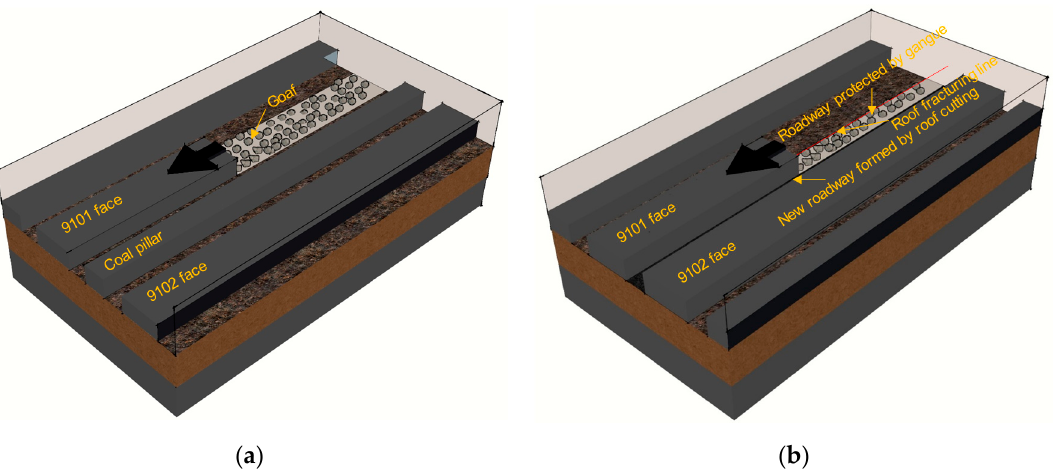
Figure 3. Layout of mining mode. ( a ) Layout of traditional mining mode; ( b ) Layout of non-pillar mining mode.